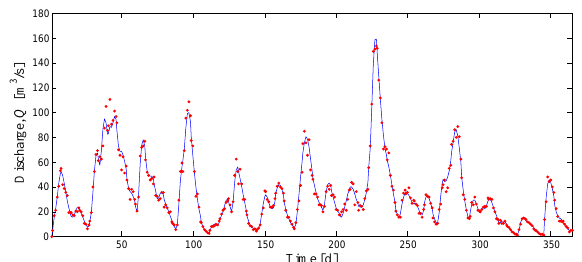
Fig. 2. Synthetic discharge time series (blue line) simulated with the Nash cascade model, and the corrupted observations (red points) used in the GLUE and ABC analysis.